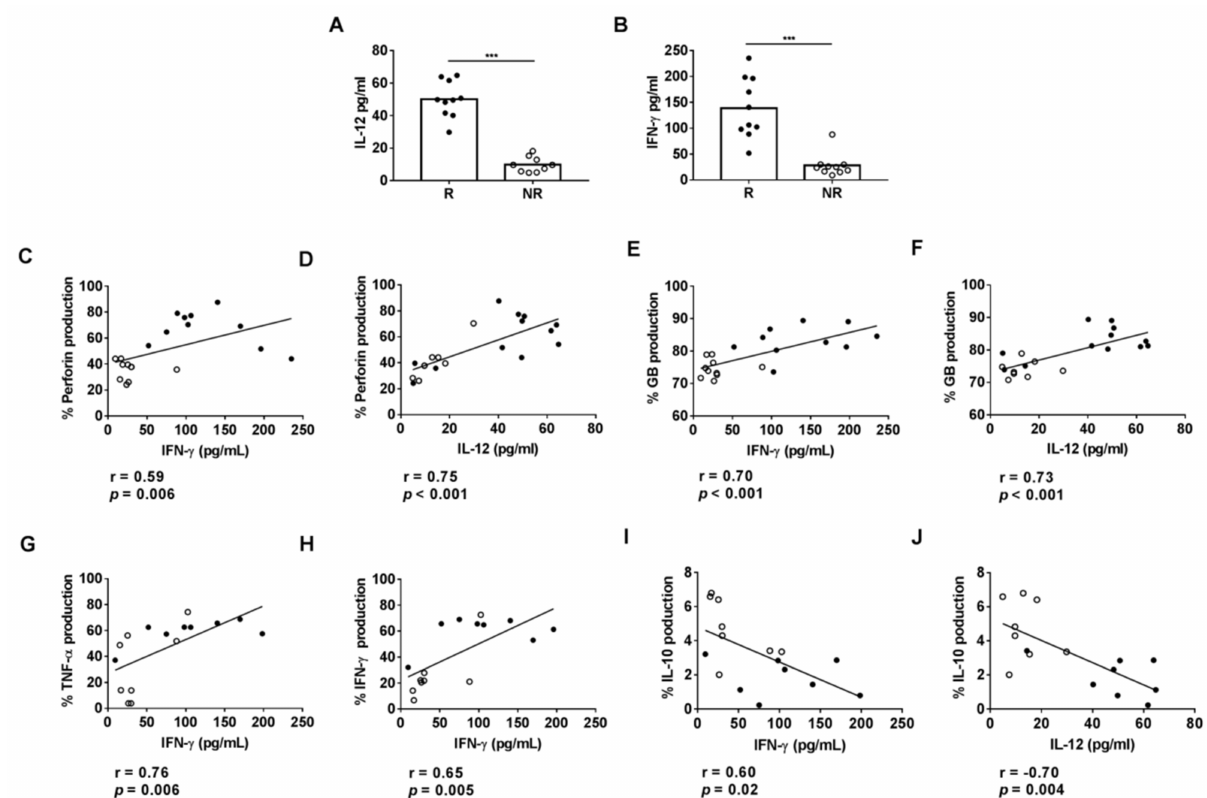
Figure 5. ( A , B ) Plasmatic levels of IFN- γ and IL-12 cytokines determined by ELISA in R ( n = 10) and NR ( n = 10) patients. ( C – J ) Relationship with the percentage of CD8+ HLA-DR+ T cells producing cytokines and cytotoxic granules after 72 h culture of HD PBMCs with plasma from R and NR patients. Spots in black correspond to R plasma and spots in white to NR plasma. *** p <